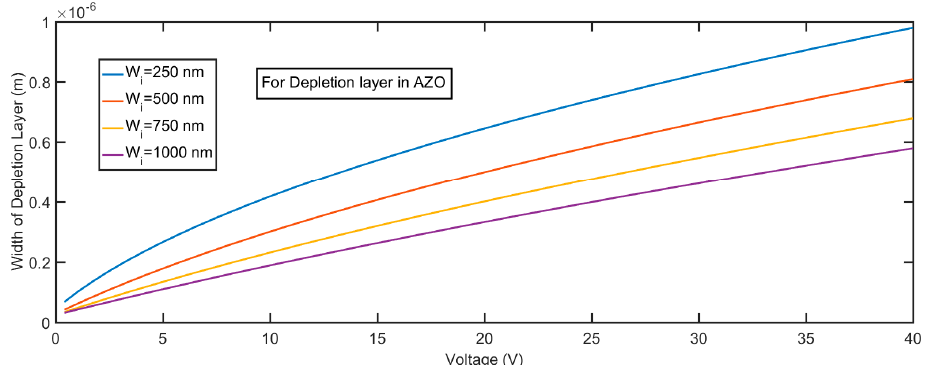
Figure 9. Width of the depletion layer in p-Si for the p-Si/i-ZnO/n-AZO structure under different voltages.